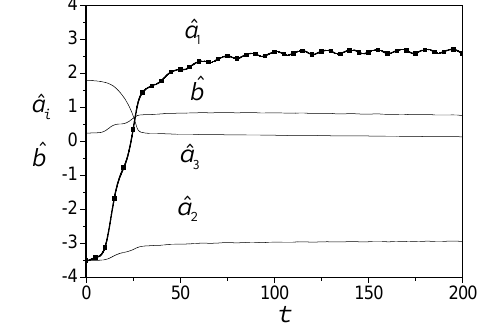
Fig. 3. Tuning of model (7) parameters.